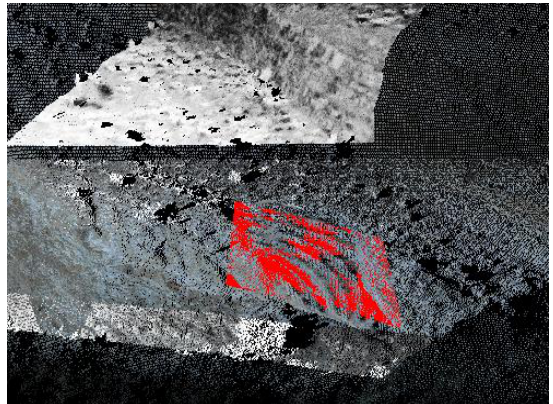
Figure 5. Interpolated plans surrounding the collapsed area